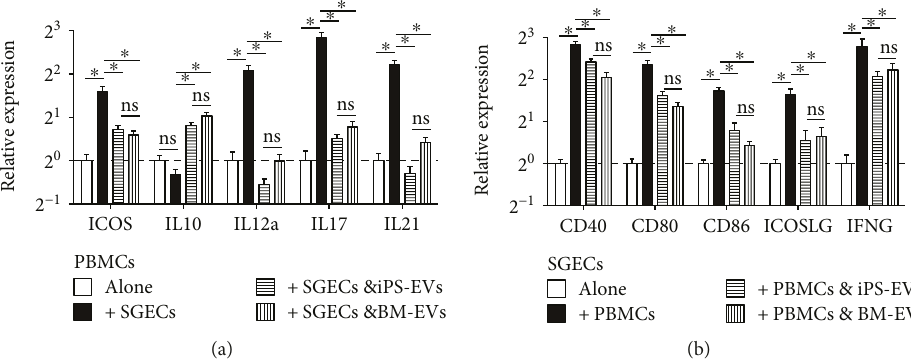
Figure 3: E ff ects of MSC EVs on gene expression of immune cells and SGECs after coculture. Human PBMCs and SGECs were cocultured at the ratio of 1: 1 for 3 days in the presence of 2.5 μ g/ml phytohemagglutinin with or without EVs derived from BM-MSCs or iPSC-MSCs (5 μ g/ml) and then examined for gene expressions in isolated PBMCs (a) and SGECs (b) by qRT-PCR. n = 3 ; ∗ P < 0 05